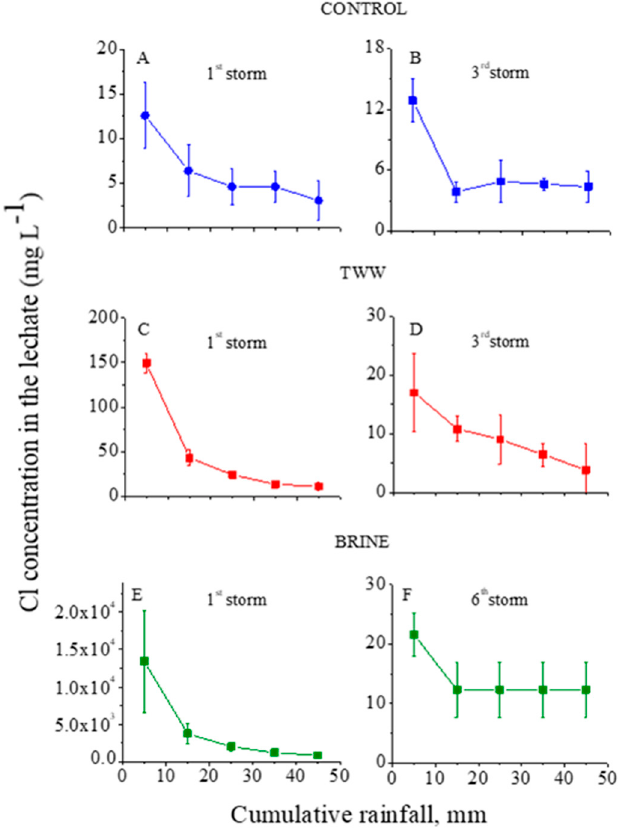
Figure 1. Cl − concentrations in the outflow leachate from the trays with treated granular materials as functions of the cumulative rainfall of the 1st ( A ) and 3rd ( B ) consecutive rainstorms for the control, of the 1st ( C ) and 3rd ( D ) consecutive rainstorms for the treated wastewater (TWW) treatment, and of the 1st ( E ) and 6th ( F ) consecutive rainstorms for the brine treatment. Vertical lines near the symbols are standard deviations (the Y-axes’ scales are different).